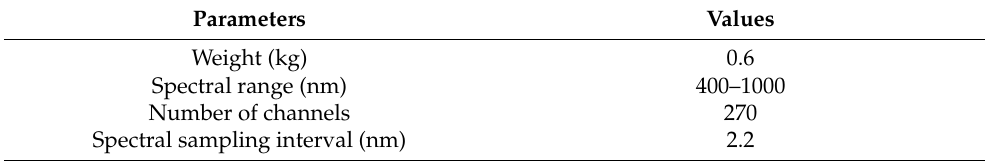
Table 2. Main parameters of Nano-Hyperspec